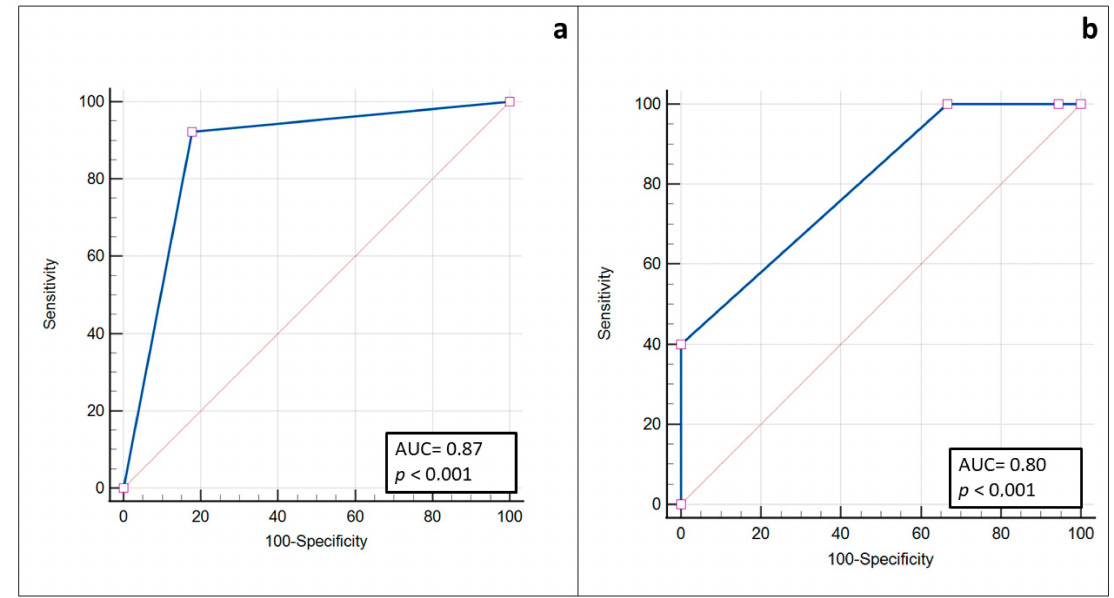
Figure 6. Receiver operating characteristic (ROC) curve for the IOUS assessment of a pDOI > 4 mm ( a ) and for differentiating invasive and noninvasive (carcinoma in situ) tumors ( b ) (blue line: ROC curve; red line: random classifier